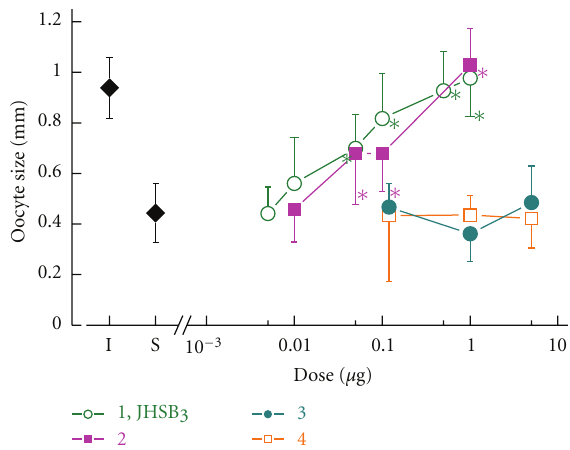
Figure 8: Reproduction-stimulating e ff ect of JHSB 3 ( 1 ) and its stereoisomers on allatectomized females of Plautia stali reared under long-day conditions. Females were allatectomized and treated with a test compound on day 4 of adult life, and oocyte diameter was determined on day 8. Solid diamonds labeled with I and S on the horizontal axis indicate results of day 8 untreated and solvent-treated adults, respectively. Each datum point and error bar represents average value ± SD ( n = 8–12). Asterisks indicate that the average value was significantly di ff erent from that of the solvent control (Steel’s test, P < 0 . 05)